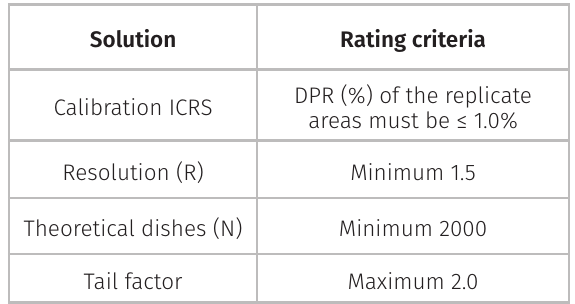
Table III. Chromatographic evaluation